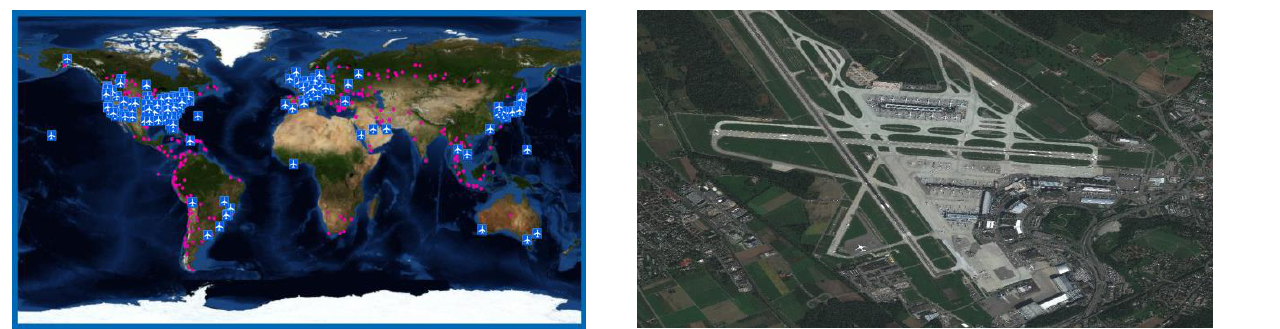
Figure 3: Ortho-Image of an Airport based on Satellite Imagery Figure 1: CompassData certified airport images and certified GCPs